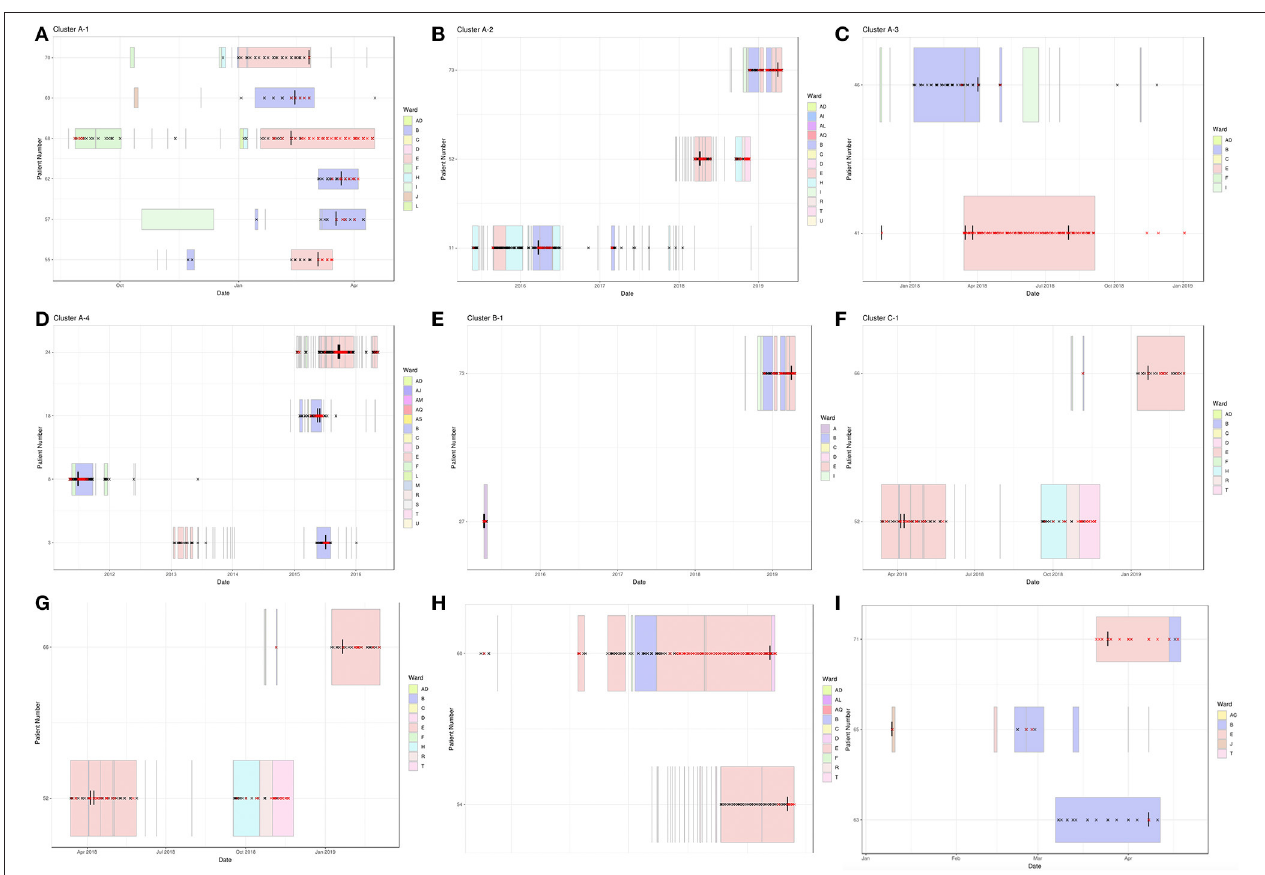
FIGURE 3 | Temporal relationship between HAdV patients forming monophyletic clusters. Clinical data were extracted from hospital databases by the GOSH Digital Research Environment (DRE) team and linked to an anonymized patient number. The ggplot2 library was used to visualize the data between positive adenovirus PCR results. Sequenced samples are indicated by a vertical black line, HAdV PCR-positive samples by a red cross, HAdV PCR-negative samples by a black cross and ward stays by colored rectangles. (A) A31 Cluster 1, (B) A31 Cluster 2, (C) A31 Cluster 3, (D) A31 Cluster 4, (E) B3 Cluster 1, (F) C2 Cluster 1, (G) C1 Cluster 2, (H) C5 Cluster 3, and (I) F41 Cluster